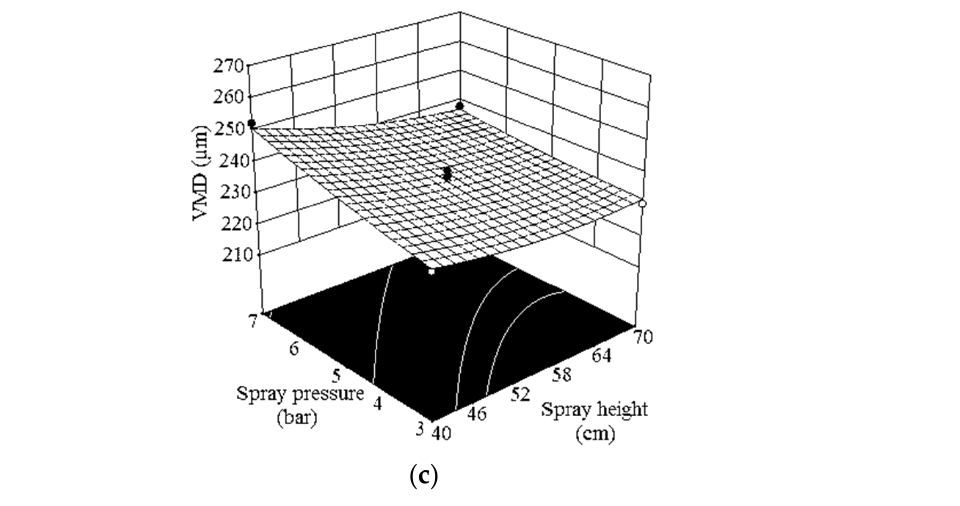
Table 7. Optimal condition, predicted and actual value, at optimized spray